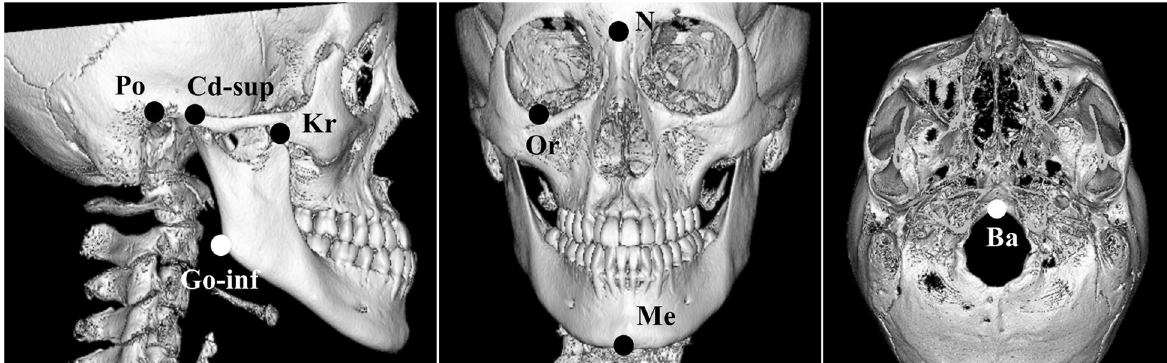
Fig. 1 Measurement points. Po: Most superior point of the external acoustic meatus; Cd-sup: Most superior point of the condylar head; Go-inf: Most inferior point on the mandibular angle; Kr: Apex of the coronoid process; N: Most anterior point on the frontonasal suture; Or: Most inferior point on the inferior orbital margin; Me: Most inferior point on the mandibular symphysis; Ba: Most inferior point above the anterior margin of the foramen